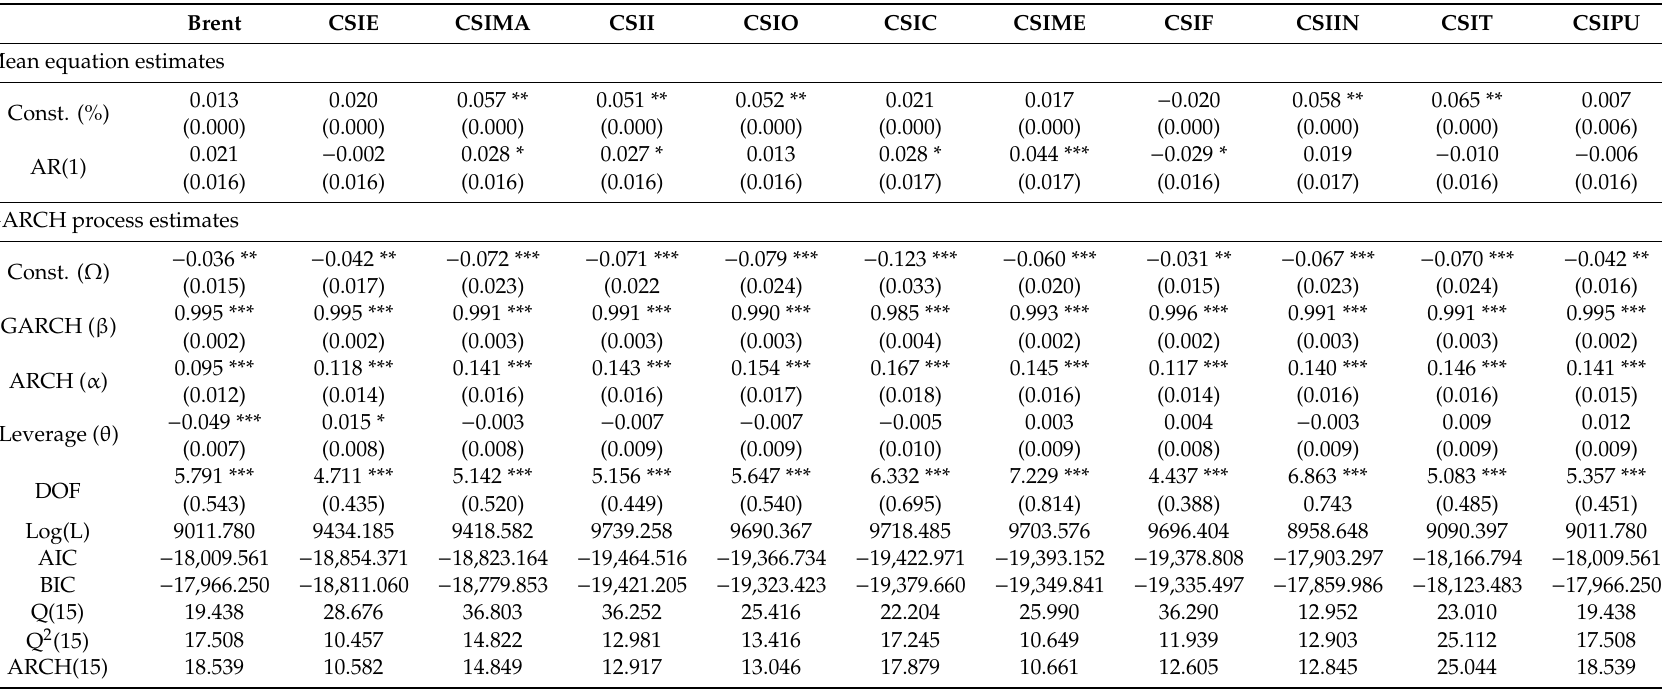
Table 3. Marginal distribution estimation results of Brent spot price and stock indexes of China Securities